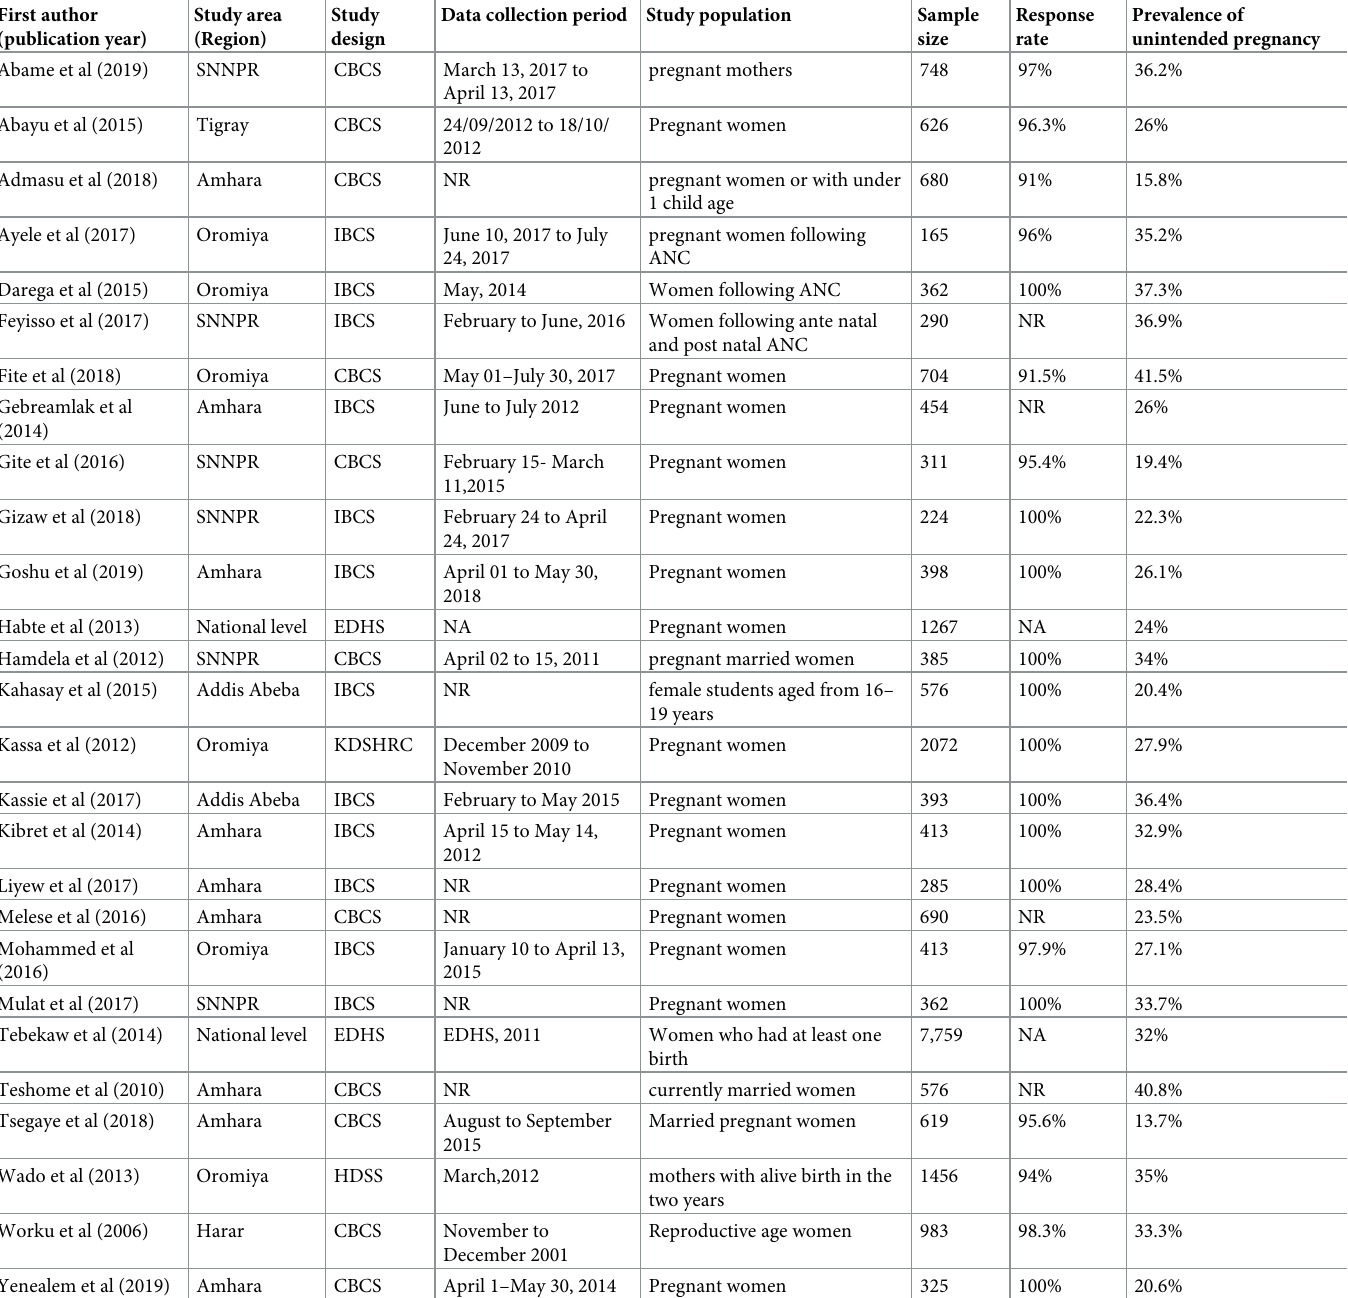
Table 1. Descriptions of the included studies conducted in Ethiopia on unintended